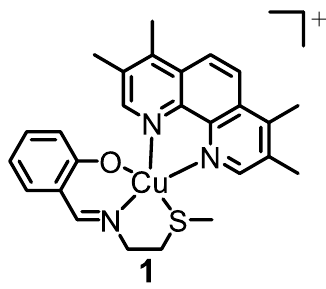
Figure 1. Chemical structure of a copper(II) complex 1 capable of killing breast CSCs via cytotoxic and immunogenic pathways. The copper(II) complex 1 will serve as the payload for the nanoparticle formulations prepared in this study.